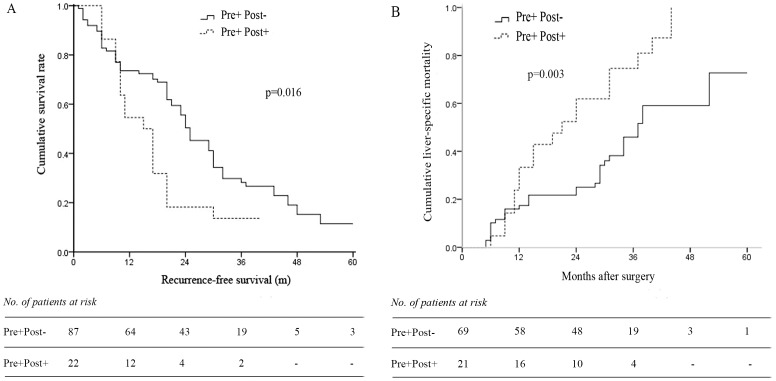
Kaplan-Meier curves for survival of patients who smoked preoperatively but quit postoperatively (Pre+ Post−) and patients who smoked preoperatively and continued postoperatively (Pre+ Post+).(A), recurrence-free survival; (B), cumulative liver-specific mortality.